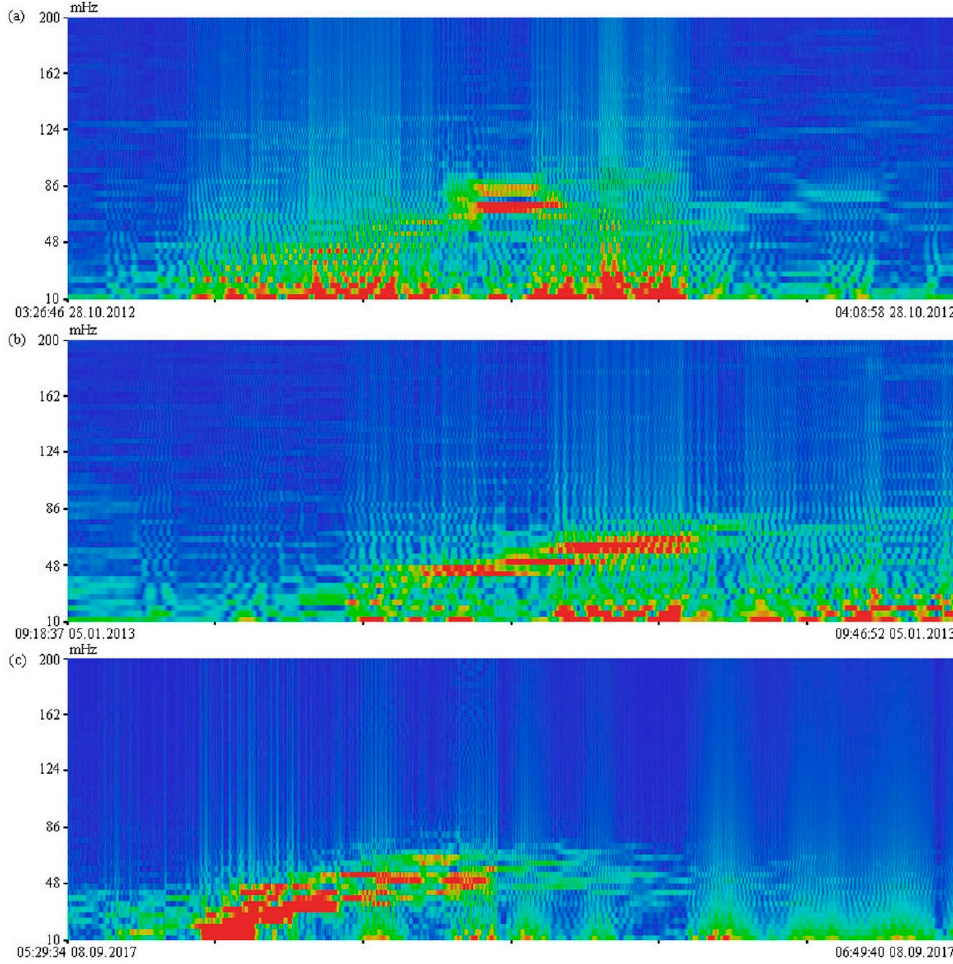
Figure 8. Dynamic spectrograms of 52.5 m laser strainmeter recordings from October 2012 ( a ), January 2013 ( b ), and September 2017 ( c ).